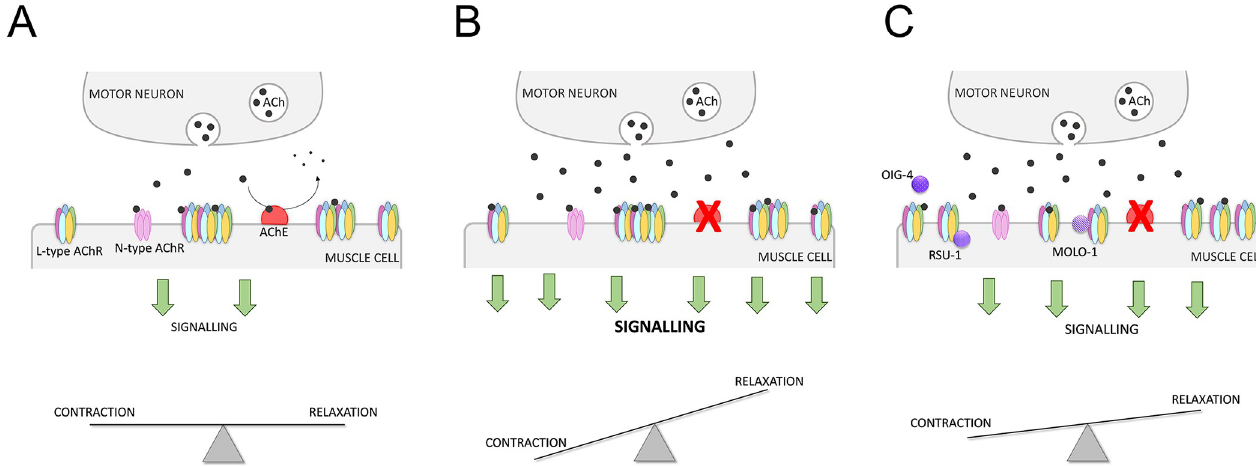
Fig 11. Hypothesised mechanism underpinning paraoxon-induced plasticity in nematodes exposed to 500 μ M paraoxon-ethyl. A) The body wall motor neuron releases acetylcholine to the neuromuscular junction that activates L-type and N-type nicotinic receptors causing the muscle contraction. In the current study this determinant is measured by scoring pharyngeal function as body wall muscle contraction leads to an associated inhibition of pharyngeal function. At the level of the body wall muscle acetylcholinesterases catalyse the breakdown of acetylcholine. This controls cholinergic transmission from the motor neuron that allows balanced excitation at the body wall muscle. B) The inhibition of the acetylcholinesterase by paraoxon-ethyl causes an increase of acetylcholine at the neuromuscular junction. This leads to the overstimulation of the cholinergic receptors expressed in the muscle fibres and, therefore the hypercontraction of the body wall muscle and an associated inhibition of pharyngeal pumping. C) Molecular determinants that impact the location and sensitivity of L-type receptors at the body wall neuromuscular junction alter the consequence of organophosphate intoxication. Further investigations are required to identify if these determinants encompassing hypo-functional L-type receptors, MOLO-1, OIG-4, RSU-1 execute their impact thought structural or functional changes of the cholinergic synapse.